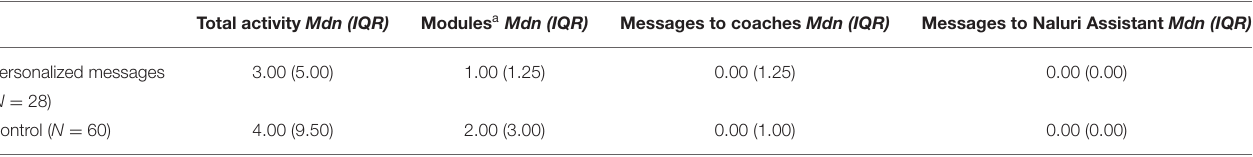
TABLE 3 | Median number of activities per user in each feature in weeks 1 to